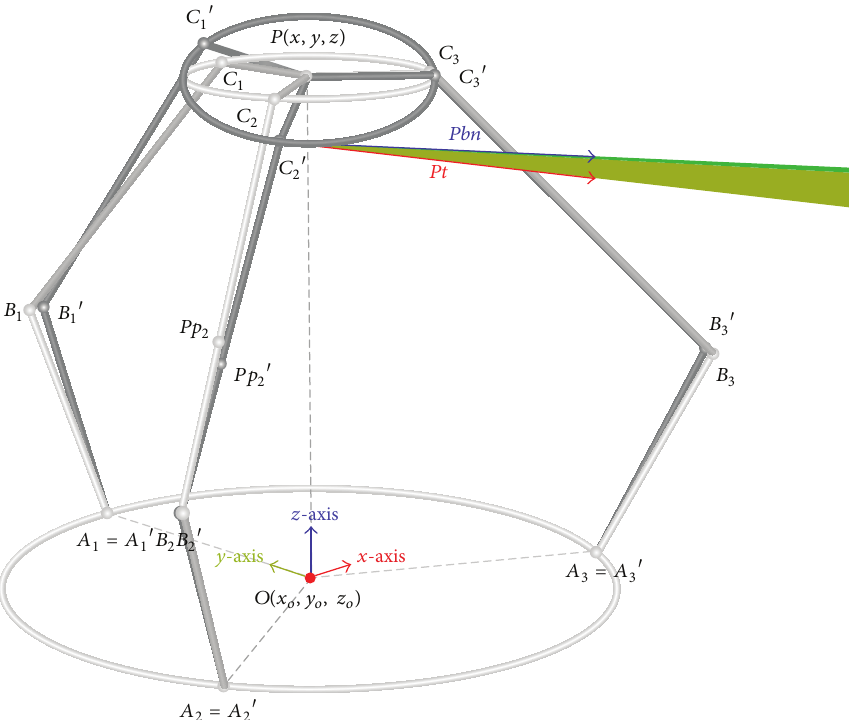
Figure 7: Cabri 3D geometric model of micromanipulator with indicated angular translation 𝛿 of piezoelectric drive.